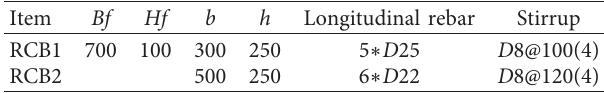
Figure 10: The schematic design of reinforcement concrete beams. Table 3: Design parameters of